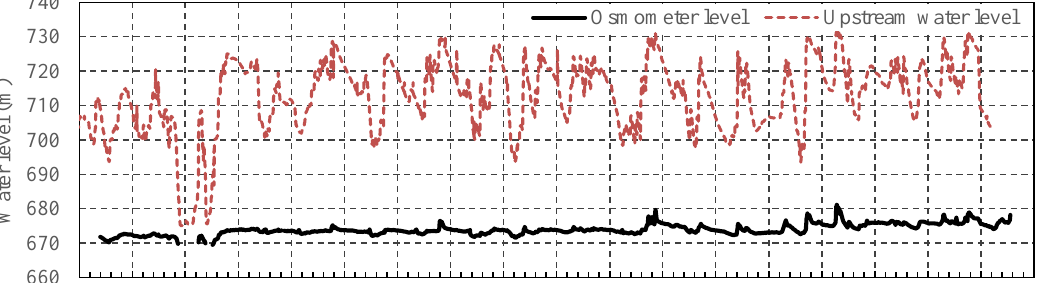
Figure 10. The hydrograph of the upstream water level and osmometer level of B3.